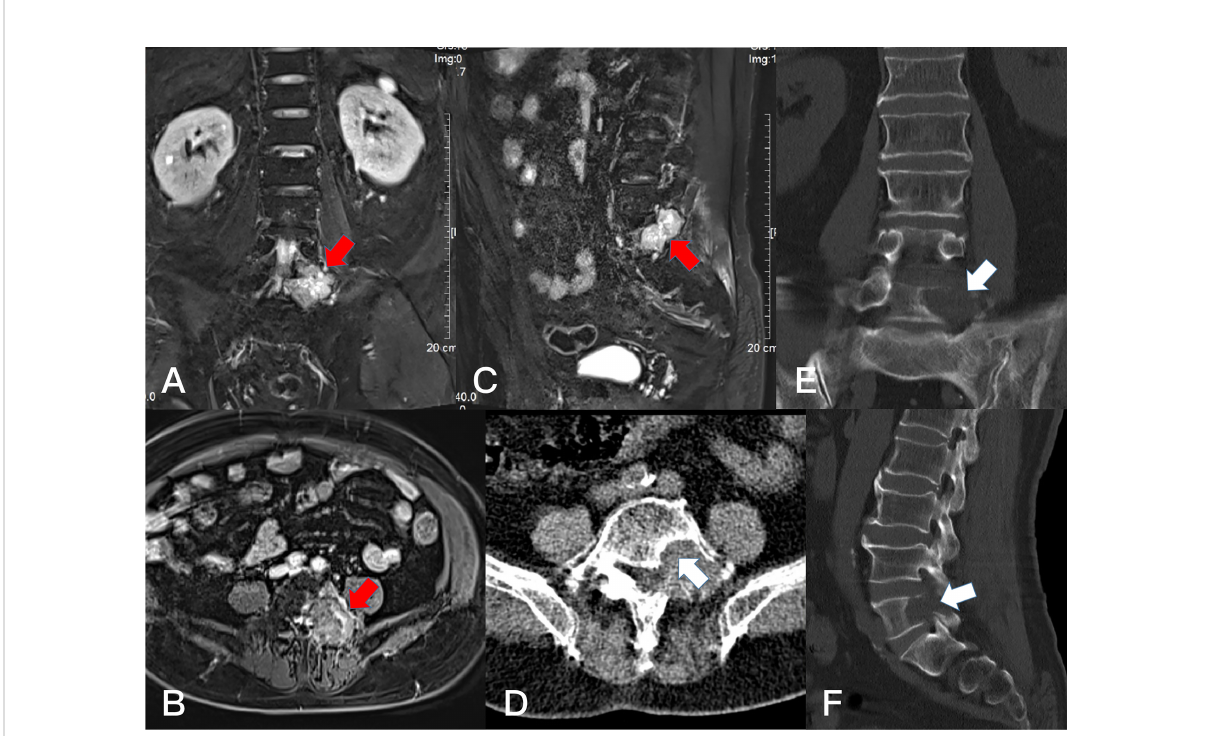
FIGURE 6 Preoperative T1-weighted enhanced MRI on coronal (A) plane, axial (B) plane, and sagittal (C) plane, revealing a dumbbell tumor (Eden III) in the left L5-S1 foramen (red arrows). The CT scan on axial (D) plane, coronal (E) plane, and sagittal (F) plane showed the bone damage of left lamina, facet joint and vertebral body of L5(white arrows).